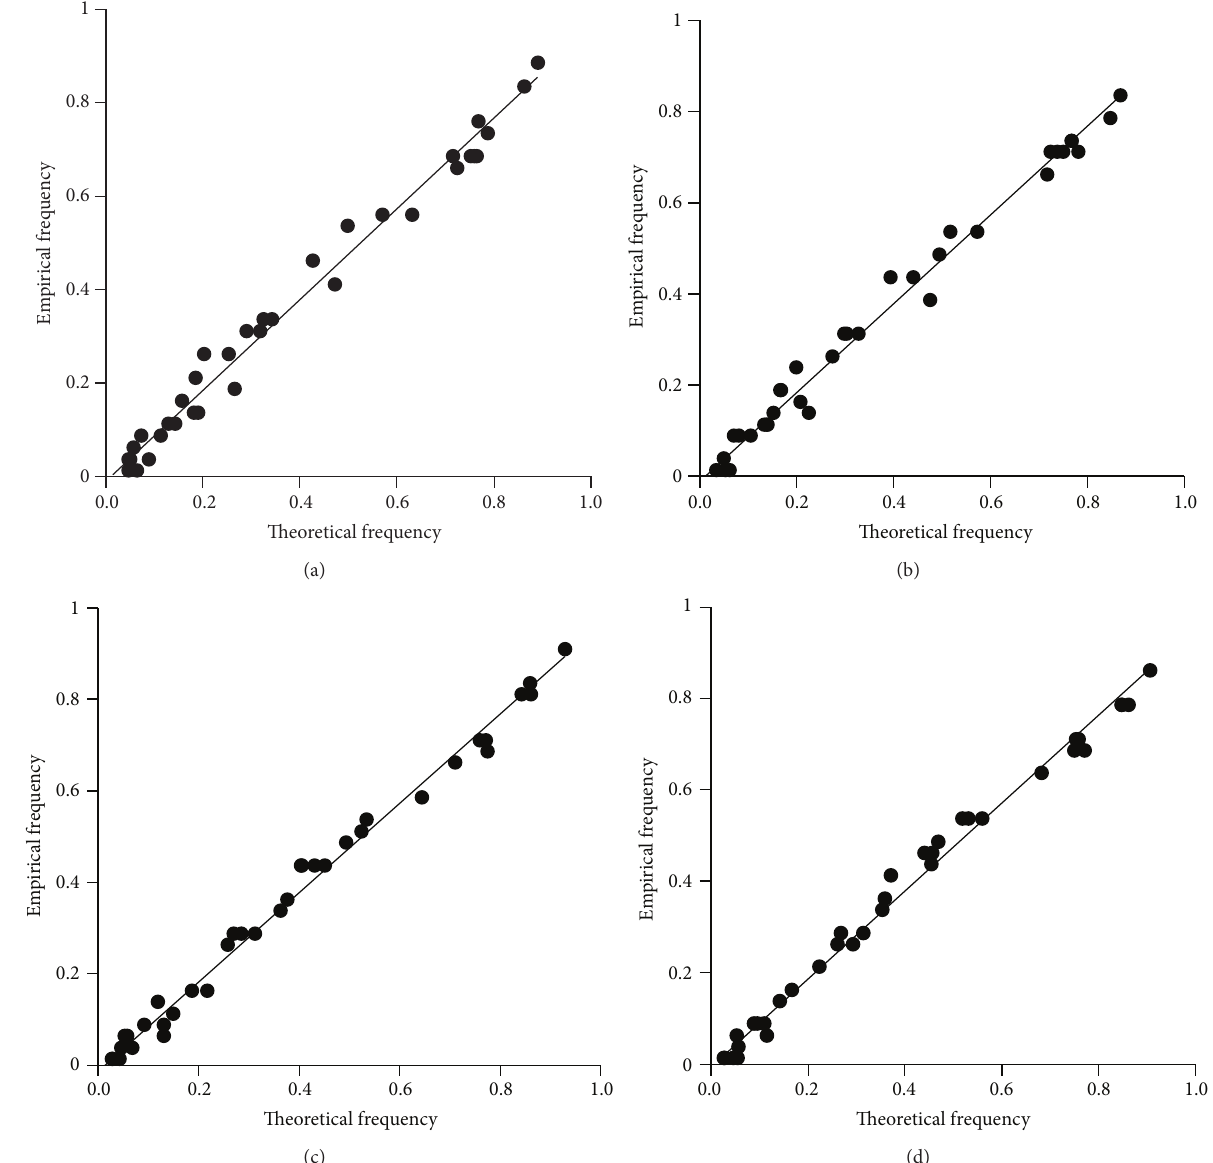
Figure 2: Empirical and theoretical frequency of 2D Frank Copula function joint distribution for different combination of the AM series: (a) X1day-W1, (b) RX1day-W3, (c) RX3day-W1, and (d)